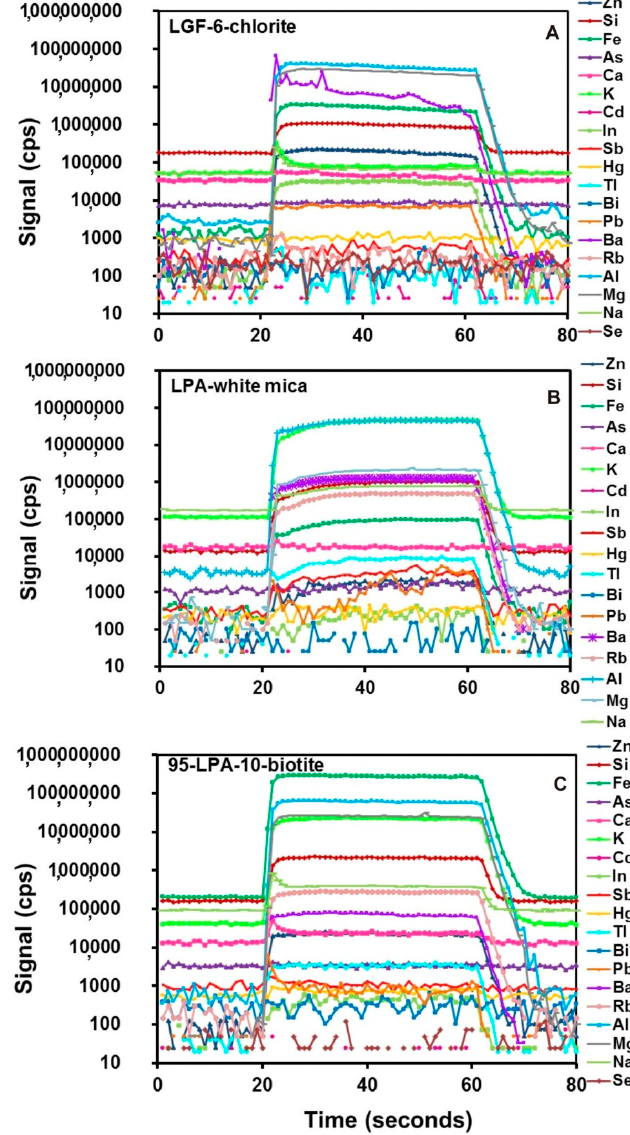
Figure 3. Single-spot laser ablation inductively coupled plasma-mass spectrometry (LA-ICP-MS) spectra for selected elements ( A ) chlorite from LGF-6 at 65.5 m, and ( B ) white mica from LGF-6 at 68 m; both ( A , B ) from Louvicourt deposit, and ( C ) 95-LPA-10 at 90 m, Heath Steele B zone deposit. These samples have the highest fluid-mobile element concentrations.